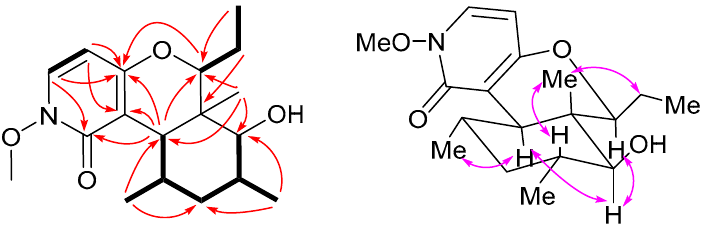
Figure 3. Key 1 H- 1 H COSY (bold), HMBC (red single-headed arrows) and NOESY (pink double-headed arrows) of 1 .